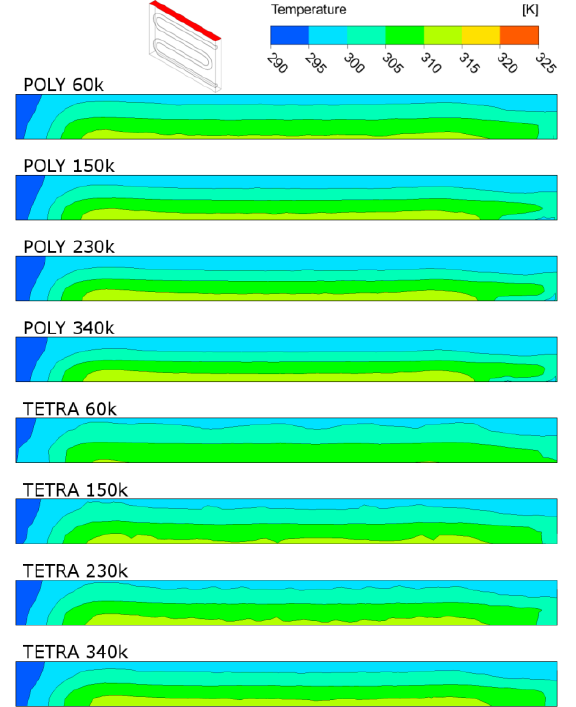
Fig. 9. Temperature distribution in the air outlet surface